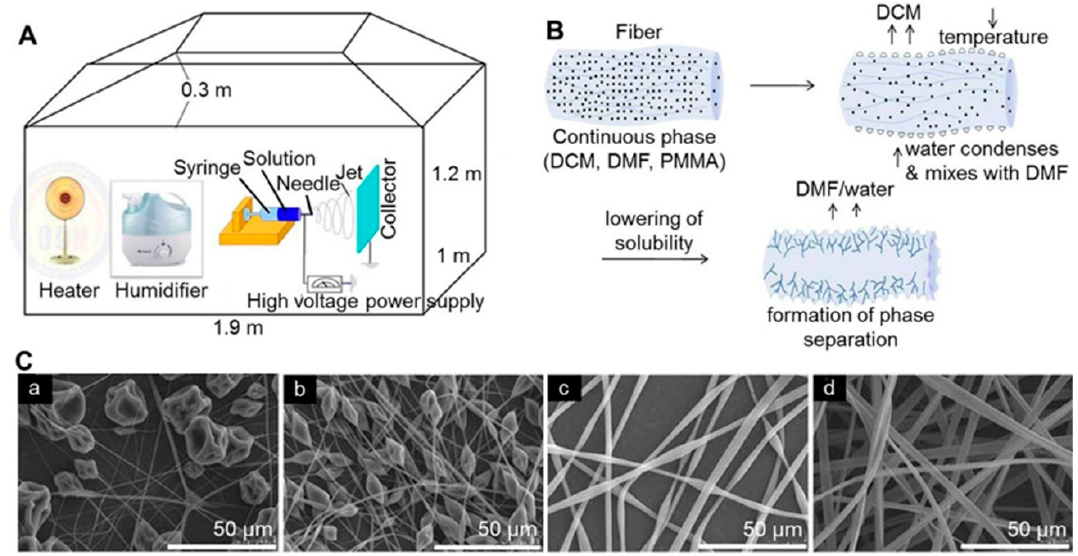
Figure 8. Preparation and characterization of electrospinning fibers with porous structure. ( A ) Schematic illustration of the electrospinning chamber for porous structure microfibers. ( B ) Schematic diagram showing the formation of pores during electrospinning. ( C ) SEM images of the electrospun PMMA fibers obtained at polymer concentrations of (a) 12, (b) 15, (c) 18, and (d) 21 wt% and at a humidity of 25%. Reproduced from [214] with permission from Springer Nature; Copyright 2013.